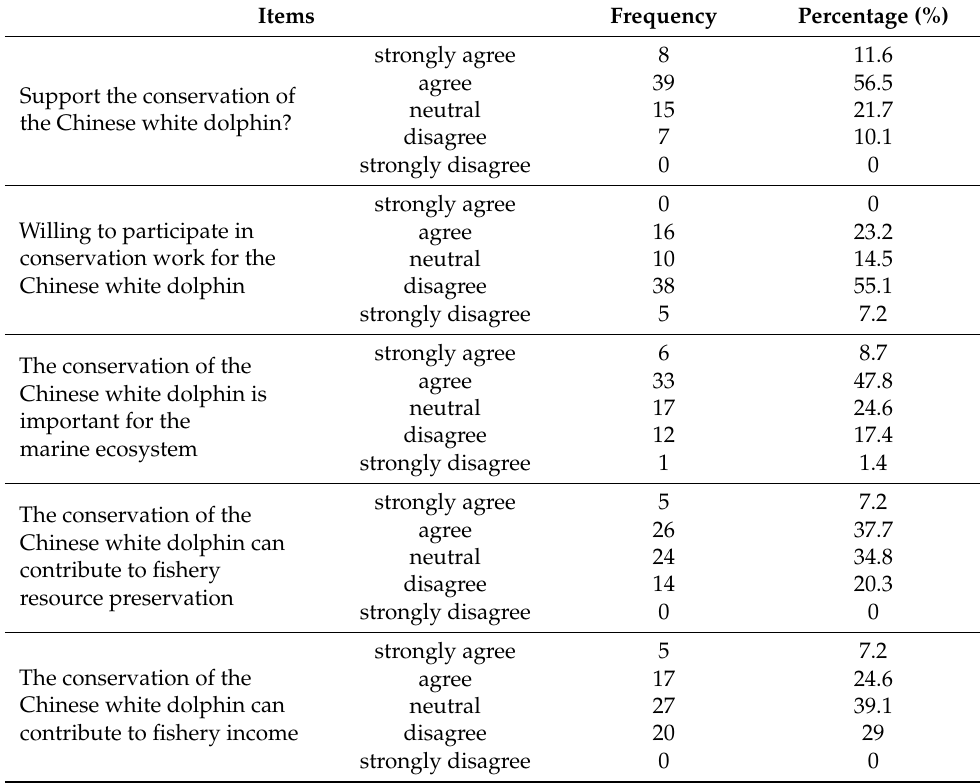
Table 3. Fishers’ opinions on the conservation of the Chinese white dolphin ( n =